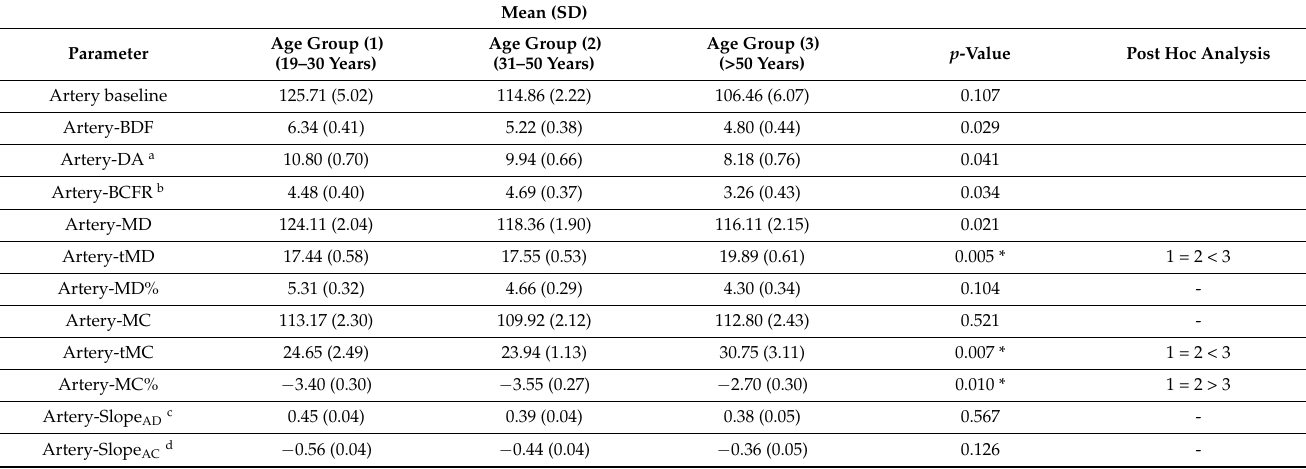
Table 2. Summary of retinal arterial vascular function